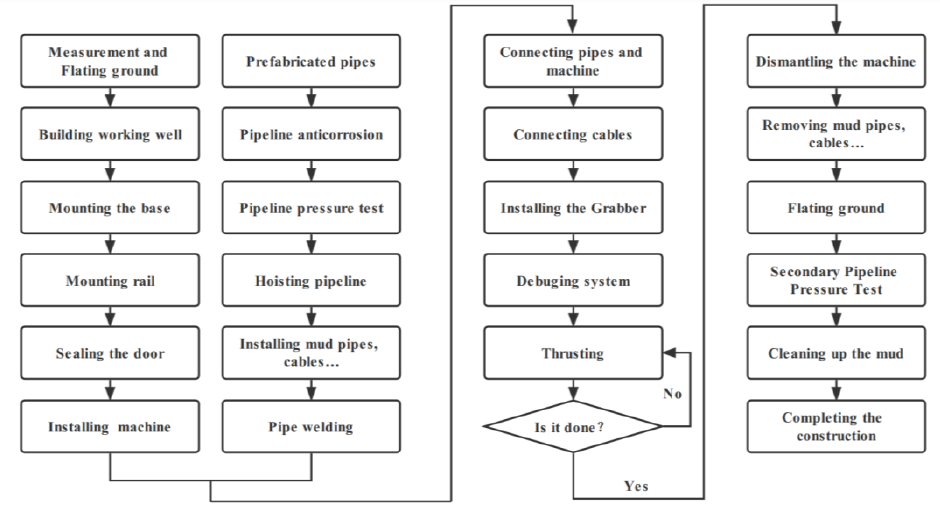
Figure 1. Flowchart of the rapid jacking and pipeline laying method.